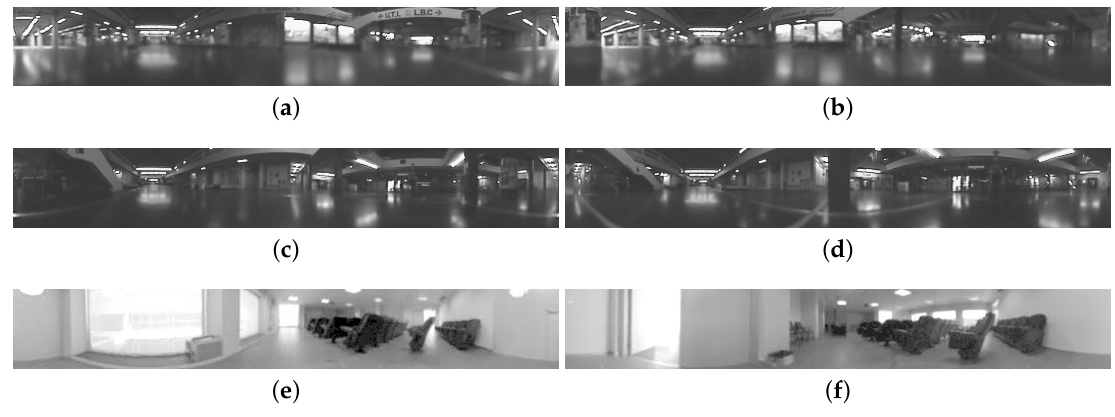
Figure 22. Sample panoramic images extracted from the database. ( a , b ) were captured from two distant positions of the hall, ( c , d ) were captured from two distant positions of the hall 2 and ( e , f ) were captured from two different poses of the events